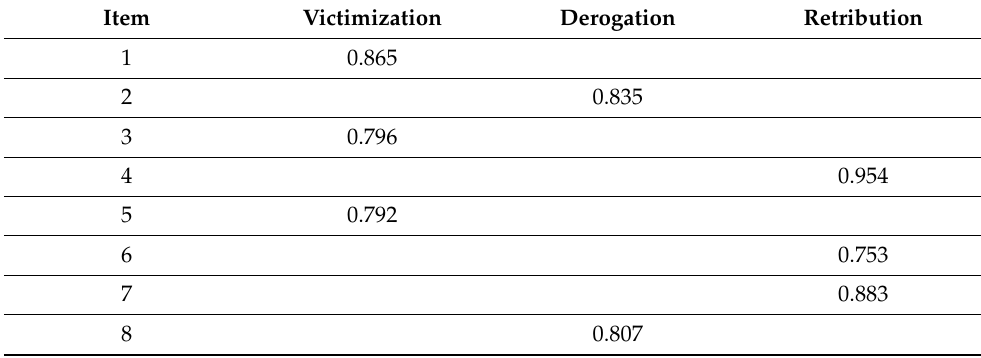
Table 3. Principal components matrix.